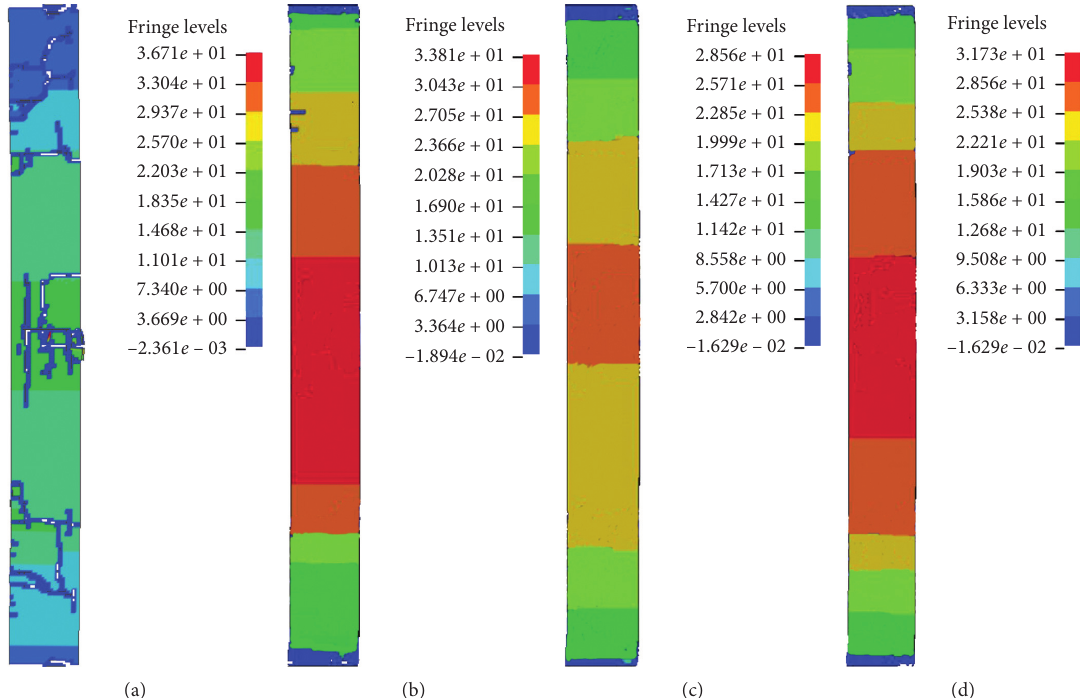
Figure 12: Damage distribution of columns retrofitted with different types of FRP (left view). (a) S-1. (b) A1-A. (c) C1-A. (d) G1-A.